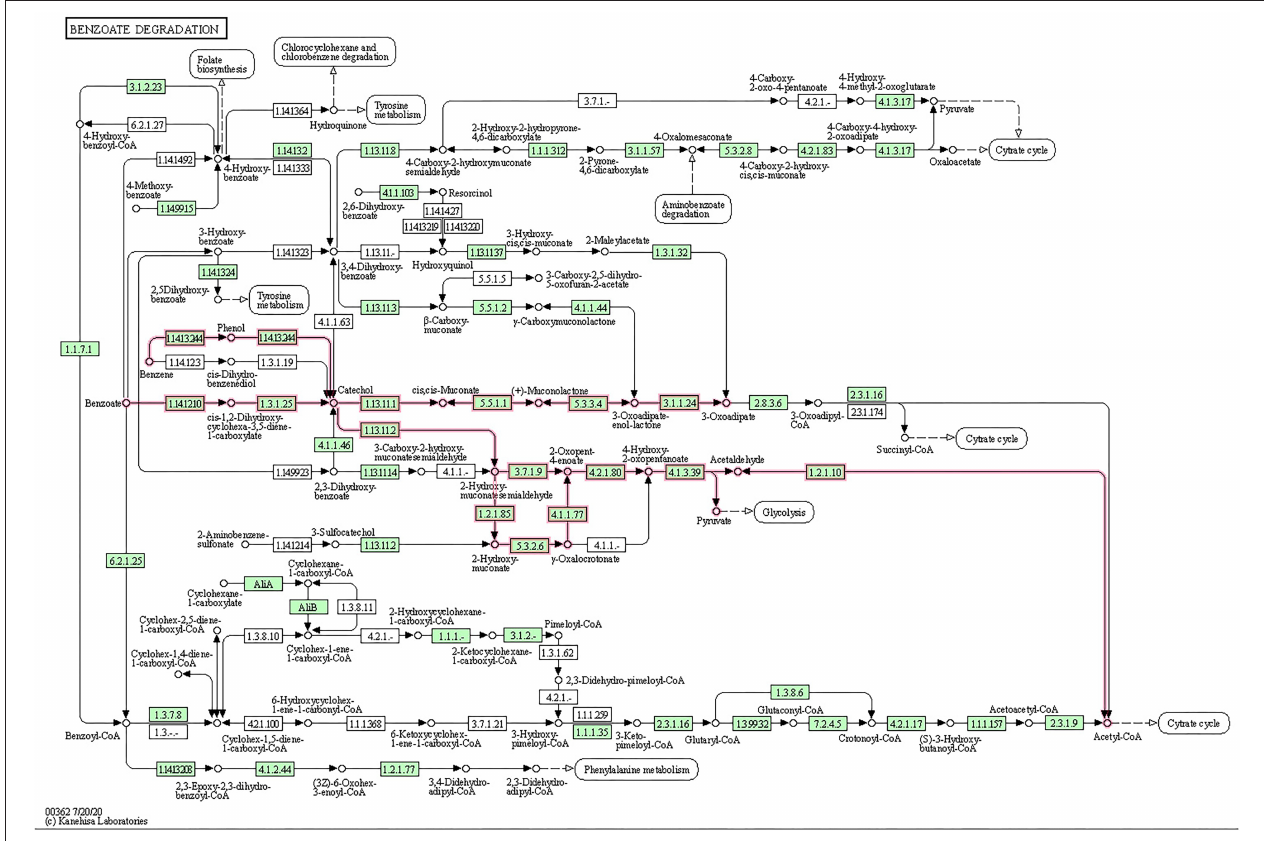
FIGURE 2 | Open reading frames (ORFs) of BS14 and SR1 mapped to benzoate biodegradation pathway.